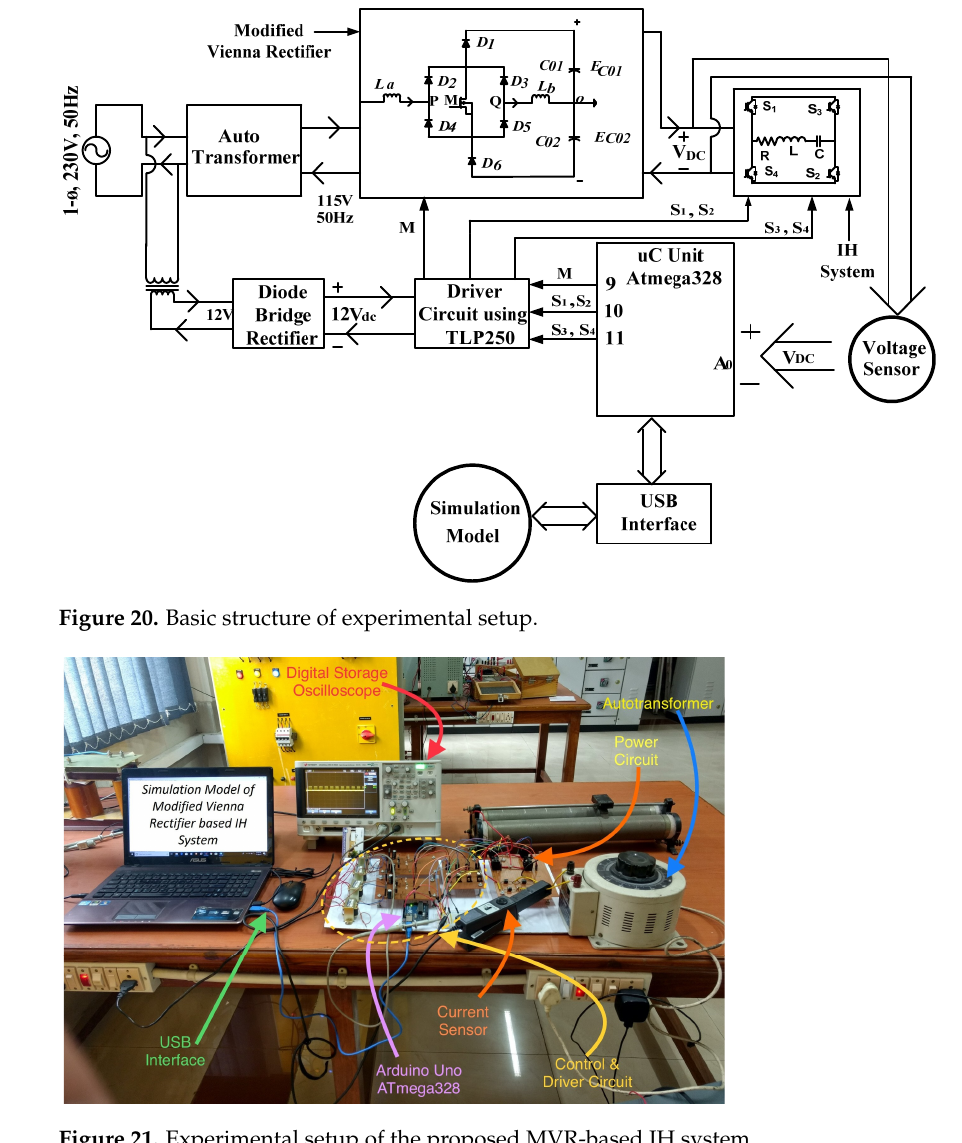
Figure 22. Structure of the pulse density modulation (PDM) controller for generation of PWM pulses. The pulses obtained from the support package are fed to the Arduino board. First of all, an ac input voltage of 230 V at 50 Hz is converted to 115 V at 50 Hz by using an au- to-transformer, then it is fed to the MVR. The latter has a boost and a buck-boost effect; thus, it converts the 115 V at 50 Hz ac to a 327 V DC value. Thereafter, it is sensed by a voltage sensor and its magnitude is reduced under the 5 V range. Now, the controller present in the Arduino board generates the switching signals for the resonant inverter of the IH system, as well as the MVR. The Arduino board has a wide range of pin configu- rations, out of which, only the analog pin on the input side and the digital pins on the output side are used in the present case. The voltage sensor feeds the analog pin A 0 on the input side, while the digital outputs obtained from pins 9, 10, and 11, comprising the PWM pulses, are fed to the gate driver circuit. The output of the MVR after being scaled-down is not just fed to the analog pin A 0 of the Arduino board, but is also com-